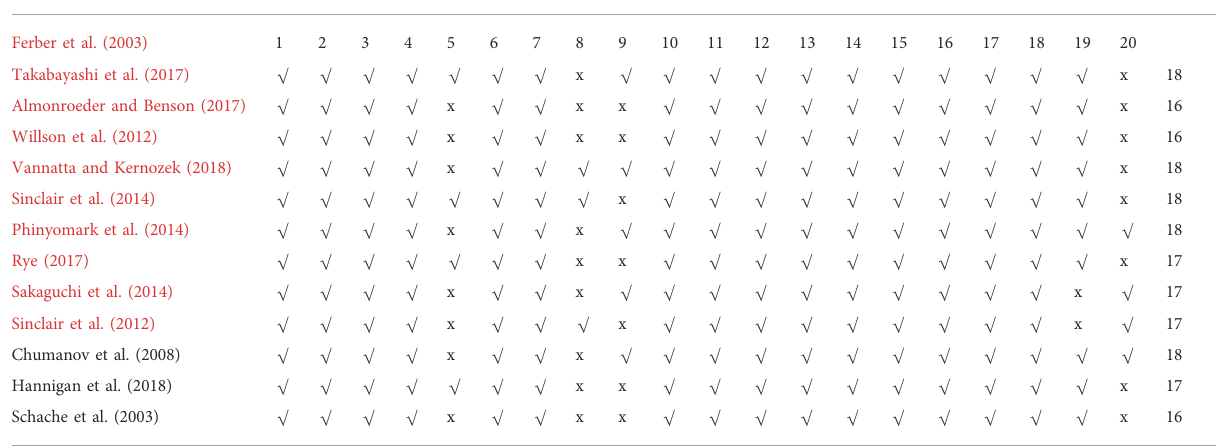
TABLE 1 Quality assessment of included